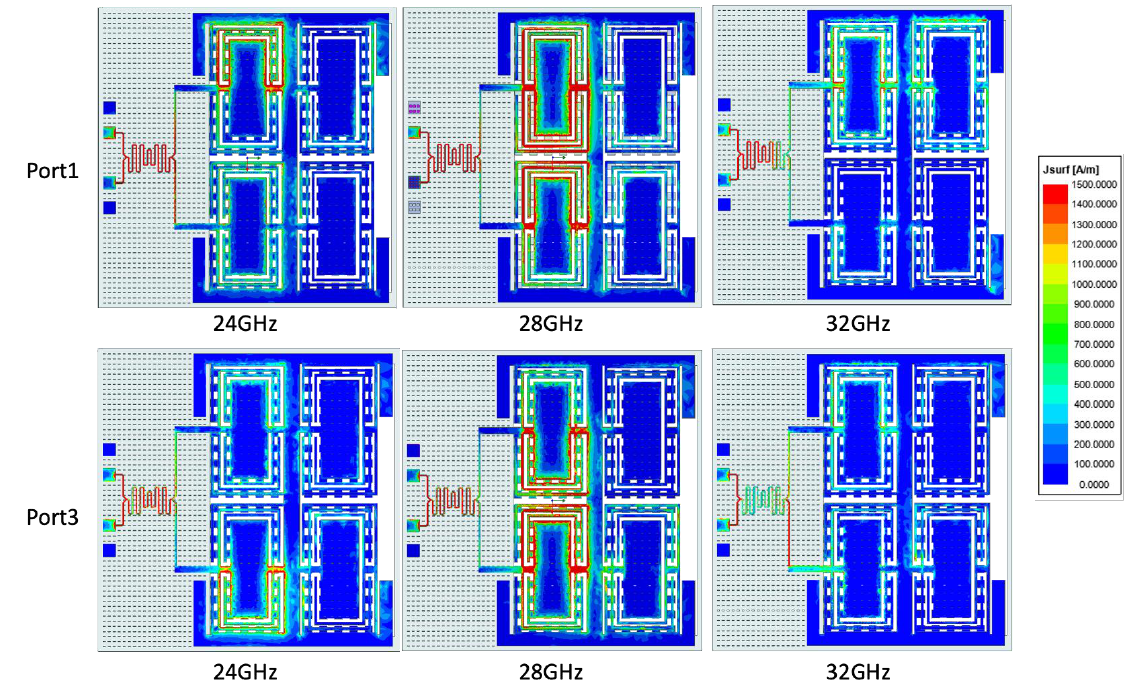
Figure 24. The proposed antennas are fed into port 1 and port 3 to observe the surface current distribution at the 24 GHz, 28 GHz, and 32 GHz frequency points.